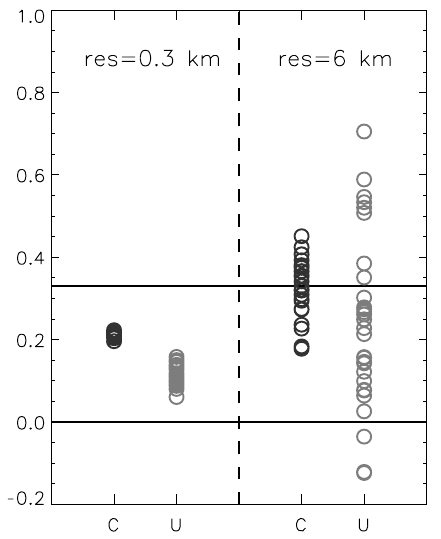
Fig. 13. Constrained (C) and unconstrained (U) ACI for the finest and coarsest resolutions of scene “c” from Fig. 4. Each set of con- strained and unconstrained values consists of 30 data points. The horizontal lines at ACI = 0 and 0.33 mark the physical limits of the